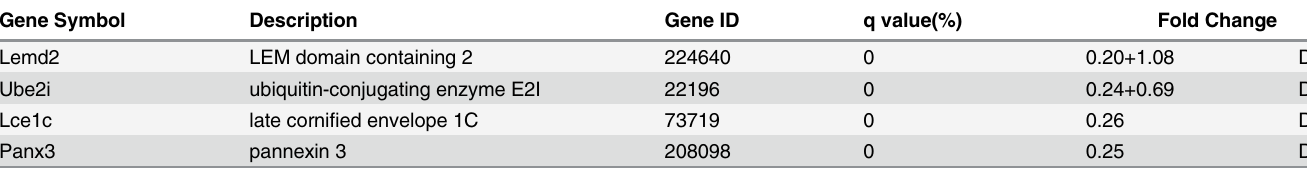
Table 2. Differentially expressed genes in KNR vs WNR